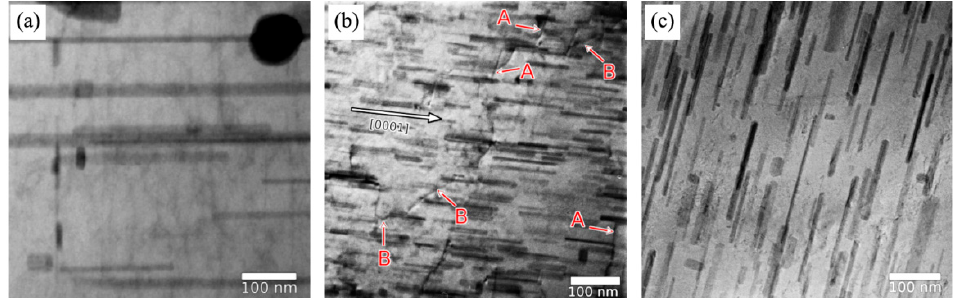
Figure 5. Transmission electron micrographs of β′ 1 rod-shaped precipitates in the peak aged condition of an extruded Mg-Zn-Y alloy, showing β′ 1 precipitates viewed normal to the hexagonal axis of magnesium for ( a ) 0%, ( b ) 3%, and ( c ) 5% pre-aging strain. Dislocations are visible in the foil given 3% strain ( b ). Segments of dislocations that are parallel to the basal plane are labelled “A” and segments of dislocations that lie at an angle to the basal plane are labelled “B” [52].